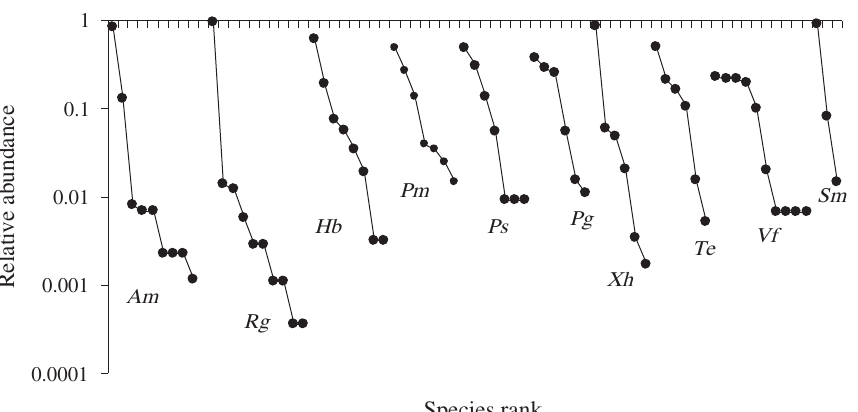
Figure 1. Patterns of relative abundance of 24 species of helminths in 11 component communities of freshwater fishes from Río Apazapan, Río La Antigua basin, Mexico (fish species: Am , A . mexicanus ; Rg , Rhamdia guatemalensis ; Hb , Pseudoxiphophorus bimaculata ; Pm , Poecilia mexicana ; Ps , P . sphenops ; Pg , Poeciliopsis gracilis ; Xh , Xiphophorus helleri ; Te , Thorichthys helleri ; Vf , Vieja fenestrata ; Sm , Sicydium gymnogaster